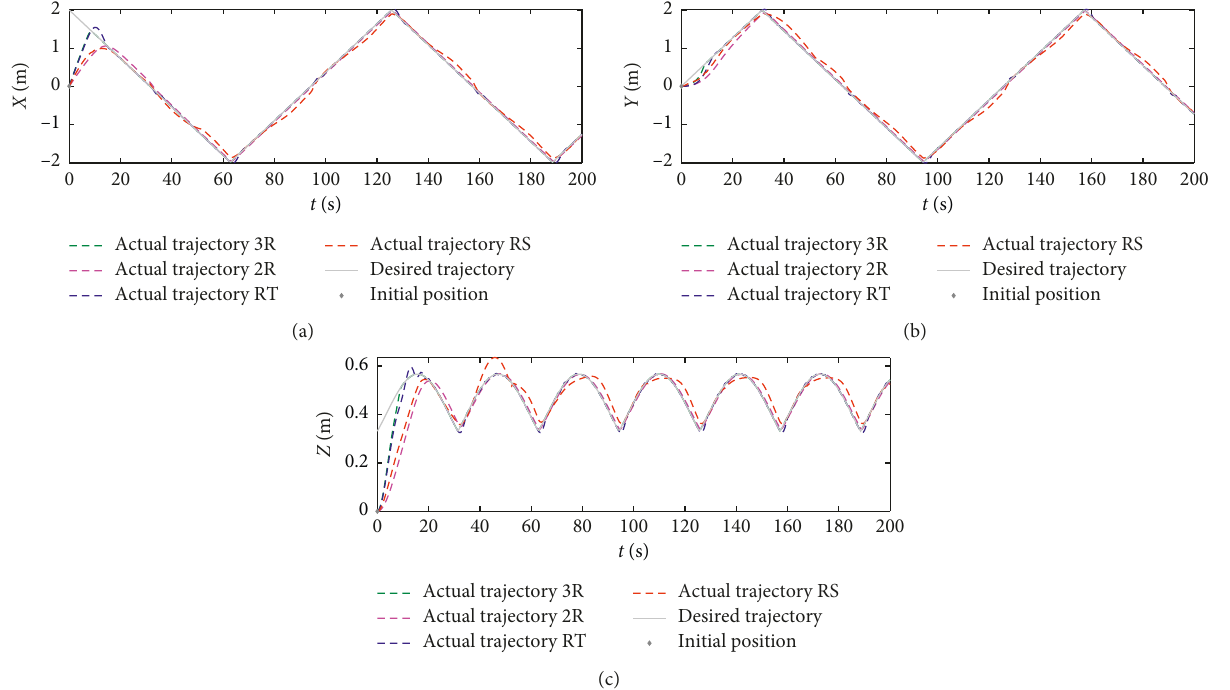
Figure 9: Robots’ actual and desired nonsmooth trajectories along X , Y , and Z directions versus